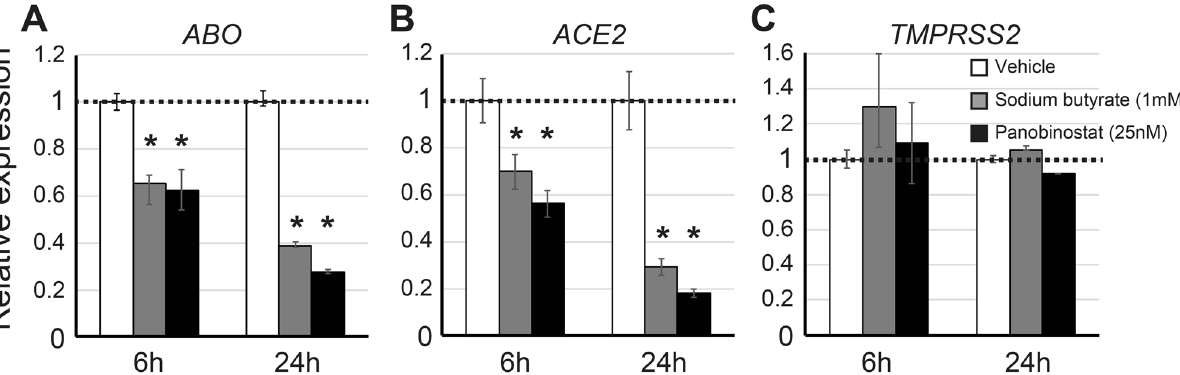
Figure 1. ABO , ACE2 and TMPRSS2 expression in KATOIII cells cultured with or without sodium butyrate or panobinostat for 6 or 24 h. ( A – C ) Relative amounts of ABO ( A ), ACE2 ( B ) and TMPRSS2 ( C ) transcripts in KATOIII cells treated with or without HDACIs such as sodium butyrate and panobinostat. Clear bars indicate the basal expression levels in the absence of HDACIs, the gray bars represent the relative amounts of transcripts in the presence of 1 mM sodium butyrate, and the solid bars denote those in the presence of 25 nM panobinostat. The graphs express mean fold values relative to those without HDACI. In each panel, the left-hand bars show the results obtained 6 h after incubation with or without HDACIs, while the right-hand bars show data 24 h after treatment. The asterisks represent a significant reduction compared to the values without HDACI ( p <